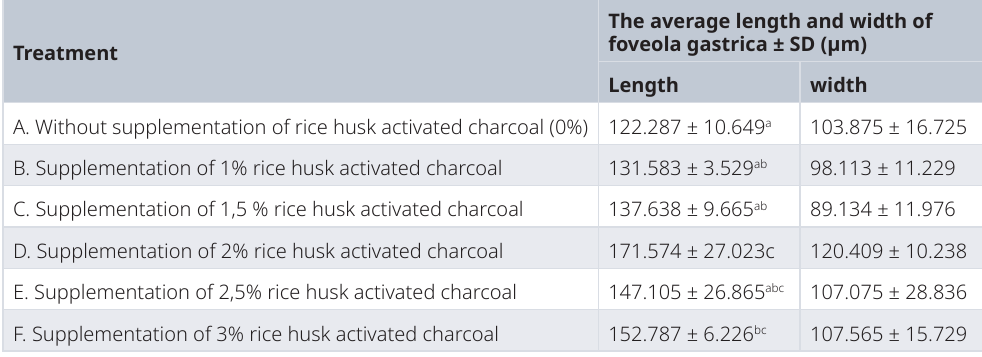
Table 4. Average length and width of the foveola gastrica.